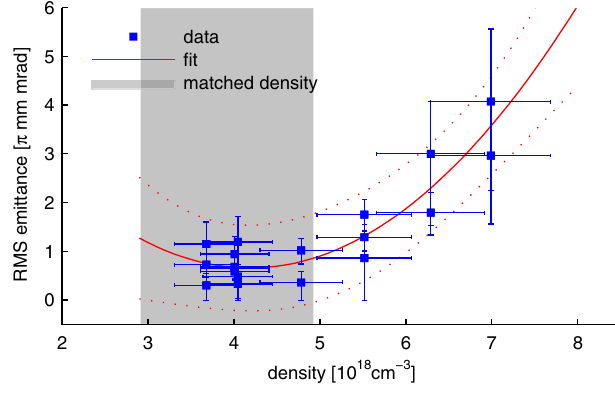
FIG. 4. Experimentally determined emittance as a function of density (blue squares). Fit with a polynomial of 2nd order (red solid line), giving R 2 ¼ 0 : 85 and 95% confidence interval (dashed red). The vertical grey lines indicate the density interval for which the spot size w 0 ¼ r b and pulse duration c (cid:5) t L ¼ r b matches the bubble radius. Error bars are propagated from errors in x-ray source size and electron energy.